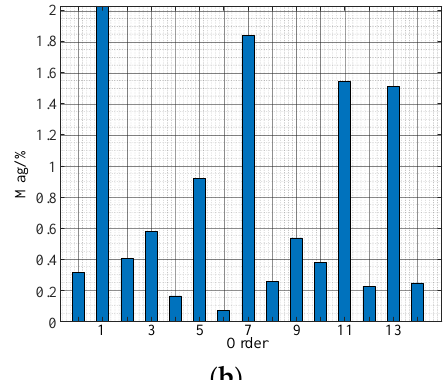
Figure 19. The FFT analysis results of the stator current under different resonant controllers. ( a )